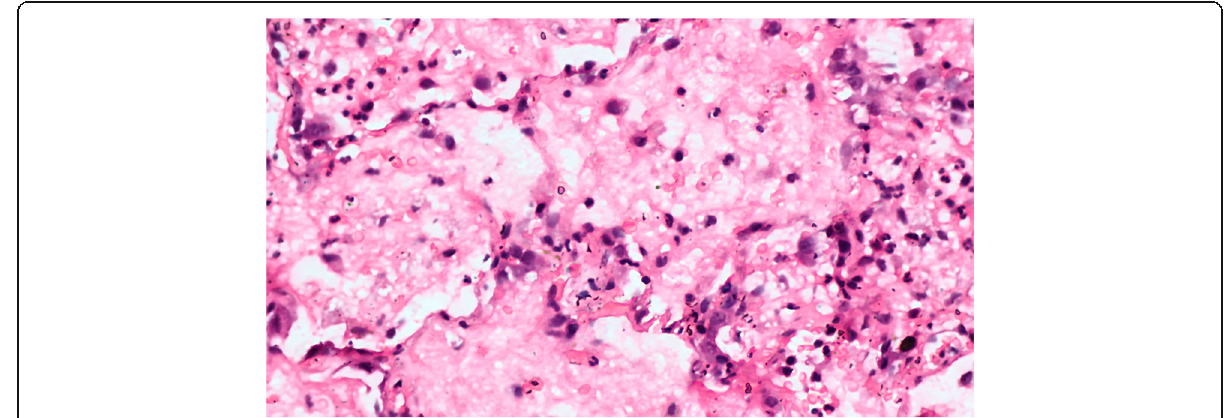
Fig. 1 Microphotograph of pulmonary tissue showing early change of diffuse alveolar damage (H&E, X200)